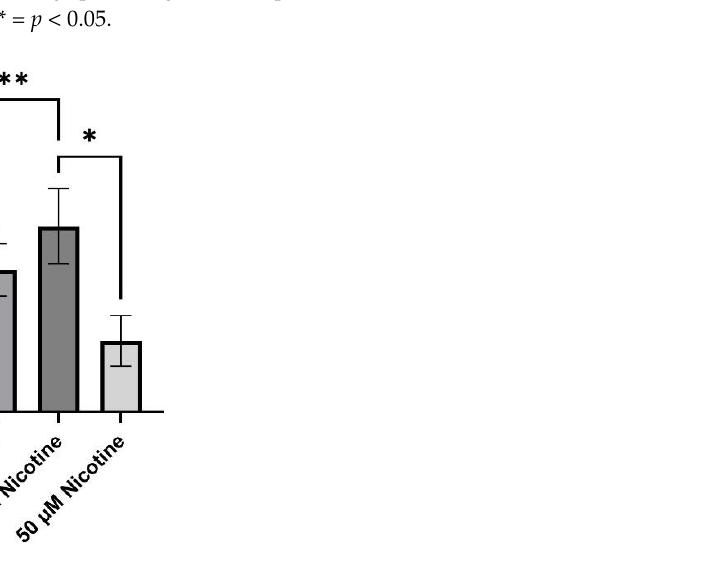
Figure 8. Embryonic nicotine exposure alters the immediate response to a social stimulus in adult zebrafish. Bars represent the time fish take to reach zone 1 once the shoal is visible. While 50 µM nicotine exposure does not change the time to reach 1 one, both the 12.5 µM and 25 µM groups were slower to reach zone 1. * = p < 0.05; ** = p < 0.01; **** = p < 0.0001.